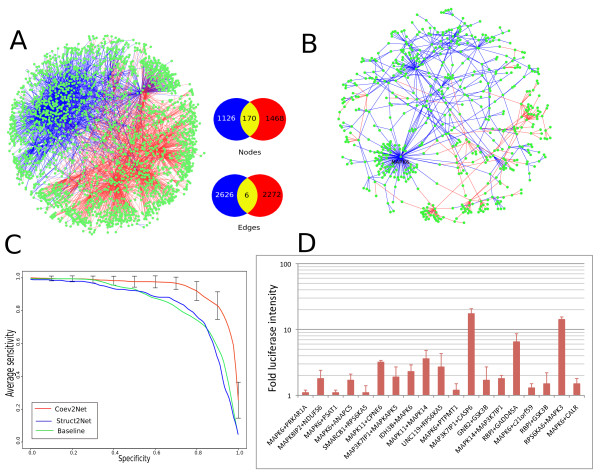
MAPK interactome analysis and validation. (a) Overlap of the Vinayagam (blue) and Bandyopadhyay (red) datasets (left). The study by Bandyopadhyay et al. reveals 2,269 interactions with 641 'core' interactions supported by multiple lines of evidence, whereas the Vinayagam dataset has 2,626 interactions connecting 1,126 proteins. Differences in the two experimental techniques are highlighted by the fact that only 170 nodes and 6 interactions overlap in the two sets. (b) Coev2Net predicted high-confidence network is shown on the right. Edge colors correspond to the dataset they come from. MAPK6 has the highest degree, and its label is shown explicitly. (c) Comparisons of performance on MAPK network for Coev2Net and Struct2Net (iWRAP+DBLRAP) [32,49,66] in terms of sensitivity and specificity. Coev2Net performs much better than previous methods on this dataset (core network of Bandyopadhyay et al.), and its performance is robust with respect to the randomness in MCMC sampling. The classifier (Figure 2) is trained and tested via five-fold cross-validation on the core network. The MCMC procedure is repeated five times to assess robustness of the predictions and the corresponding error bars are indicated. 'Baseline' method represents a logistic regression classifier with just the alignment features and no PPI (inter-protein) features. (d) Experimental validation of predicted high-confidence interactions using LUMIER assay. Typically a fold increase of 1.5 is considered as a true positive.